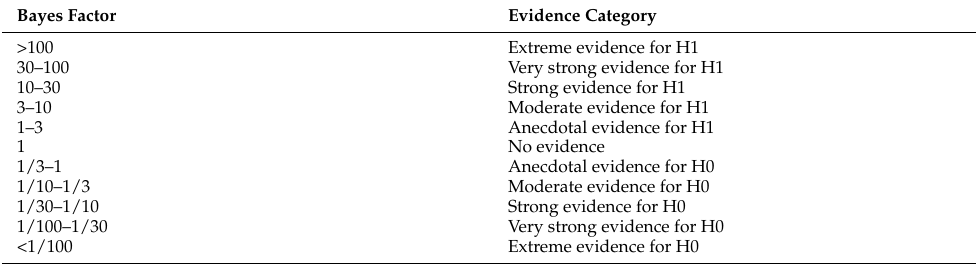
Table 2. A descriptive and approximate classification scheme for the interpretation of Bayes